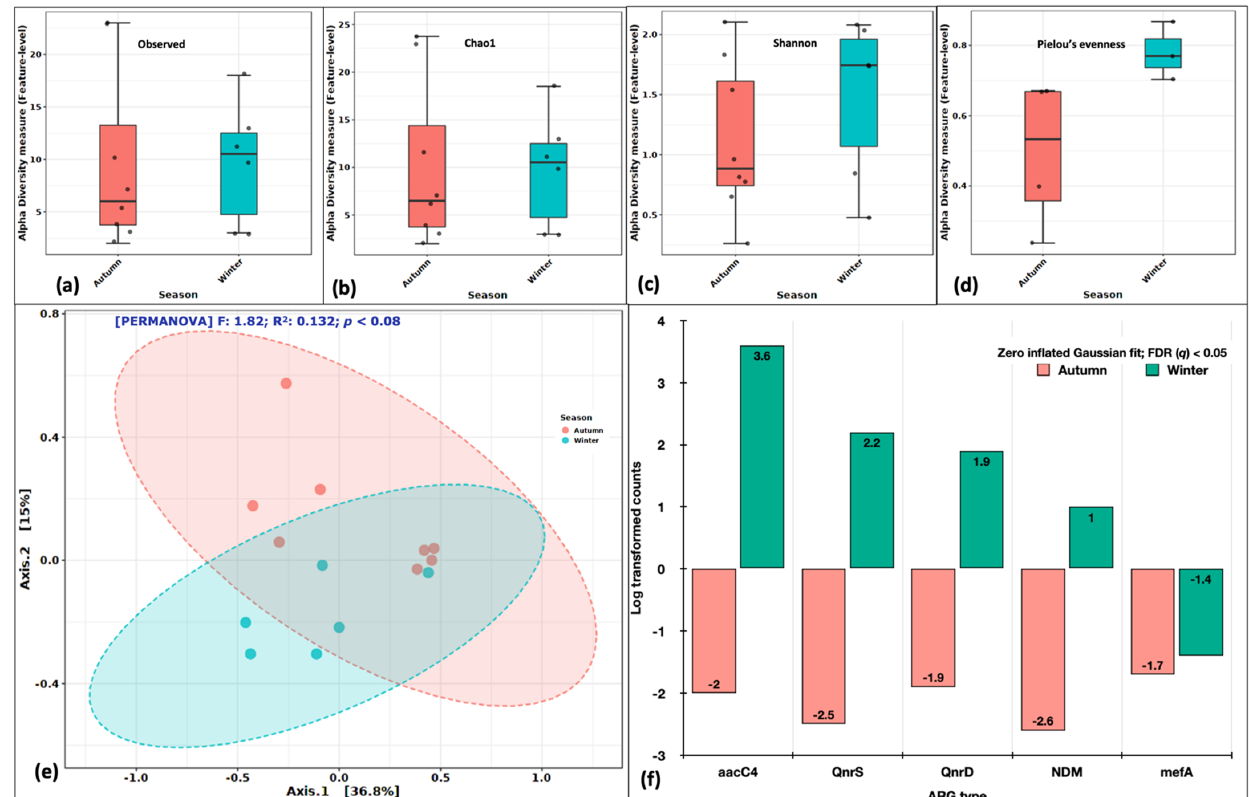
Figure 5. Variations in ARG aerosol abundance between autumn and winter seasons. Alpha diversity analysis: ( a ) Observed features, ( b ) Chao1 indices, ( c) Shannon’s evenness and richness, ( d ) Pielou’s evenness index. Beta diversity analysis: ( e ) Principal coordinate analysis (PCoA) on Bray Curtis distances through Ward algorithm. Di ff erential abundance testing: ( f ) fi tZig model (DESeq2). The green colour in each fi gure represents the indoor samples, whereas the red colour represents outdoor aerosols.